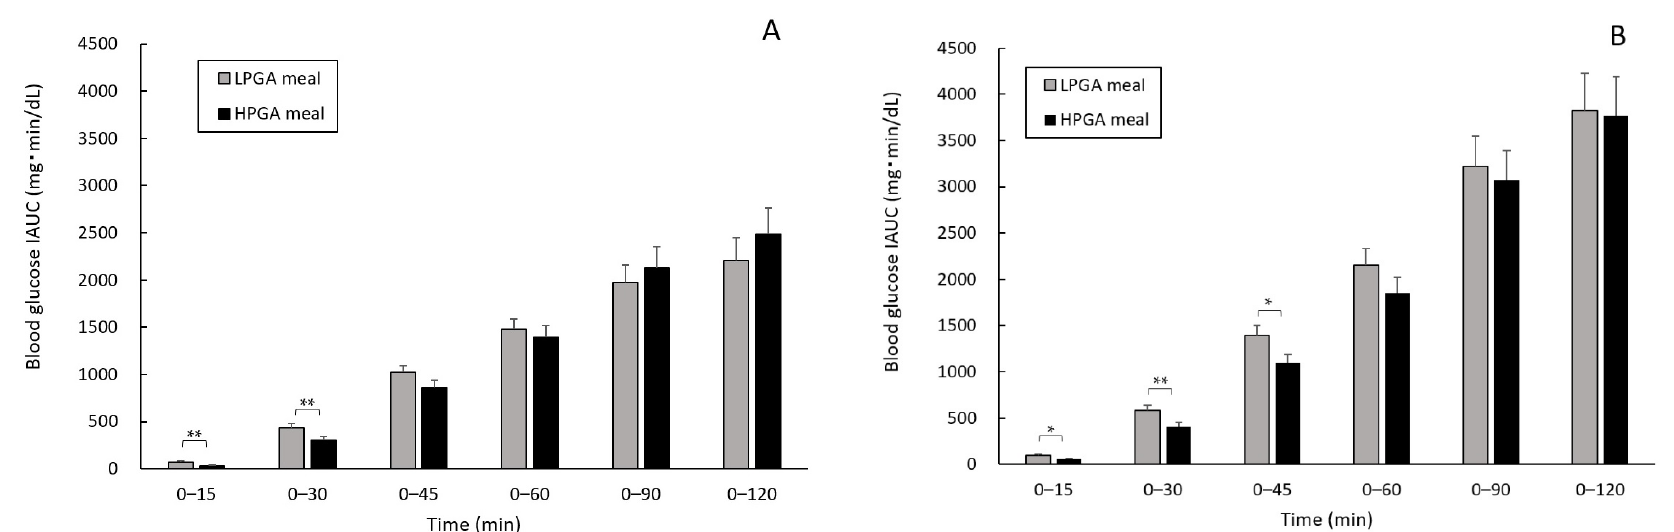
Figure 3. Effects of LPGA and HPGA meals on the levels of blood glucose IAUC in the low-glucose response group ( A ) and high-glucose response group ( B ). Linear mixed model analysis was used to compare the blood glucose IAUCs at each time point with the test meals (LPGA and HPGA meals) and groups as fixed effects, and these data are presented as the est. mean ± SE. * p < 0.05, ** p < 0.01. LPGA: low-gamma-polyglutamic acid; HPGA meal: high-gamma-polyglutamic acid; IAUC: incremental area under the curve.